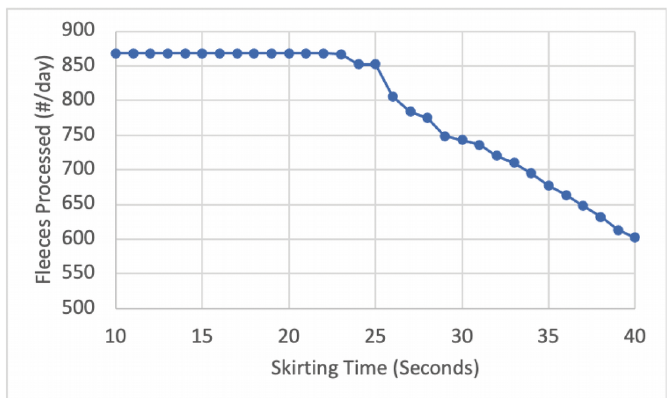
Figure 9. Number of shorn fleeces according to skirting table processing time with the optimal speed highlighted in blue